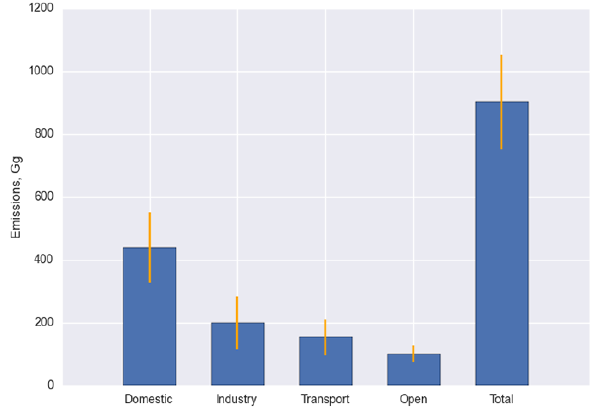
Figure 11. Mean and standard deviation for each of the major sec- tors of emissions for India, 2011.